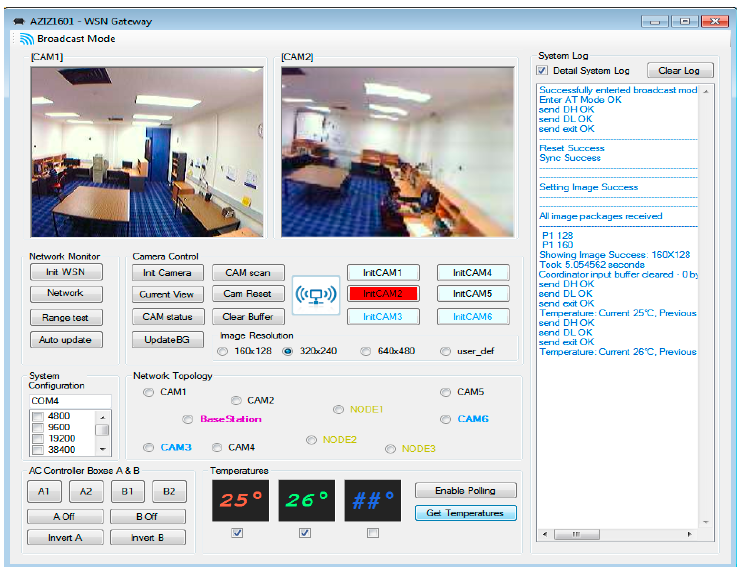
Figure 10. Graphical User Interface (GUI) at the base-station.